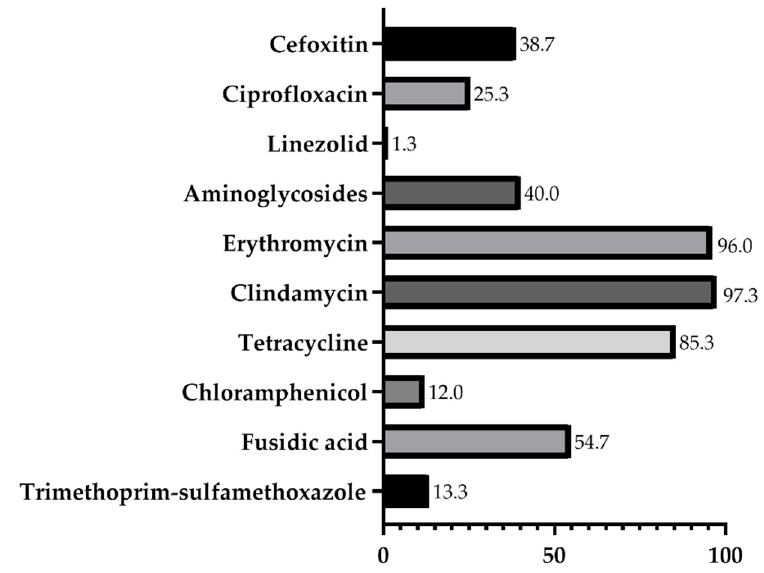
Figure 1. Percentage of resistance to each antibiotic by MRCoNS isolated from poultry. Table 2. Antimicrobial-resistant genes identified among the CoNS isolated from poultry.